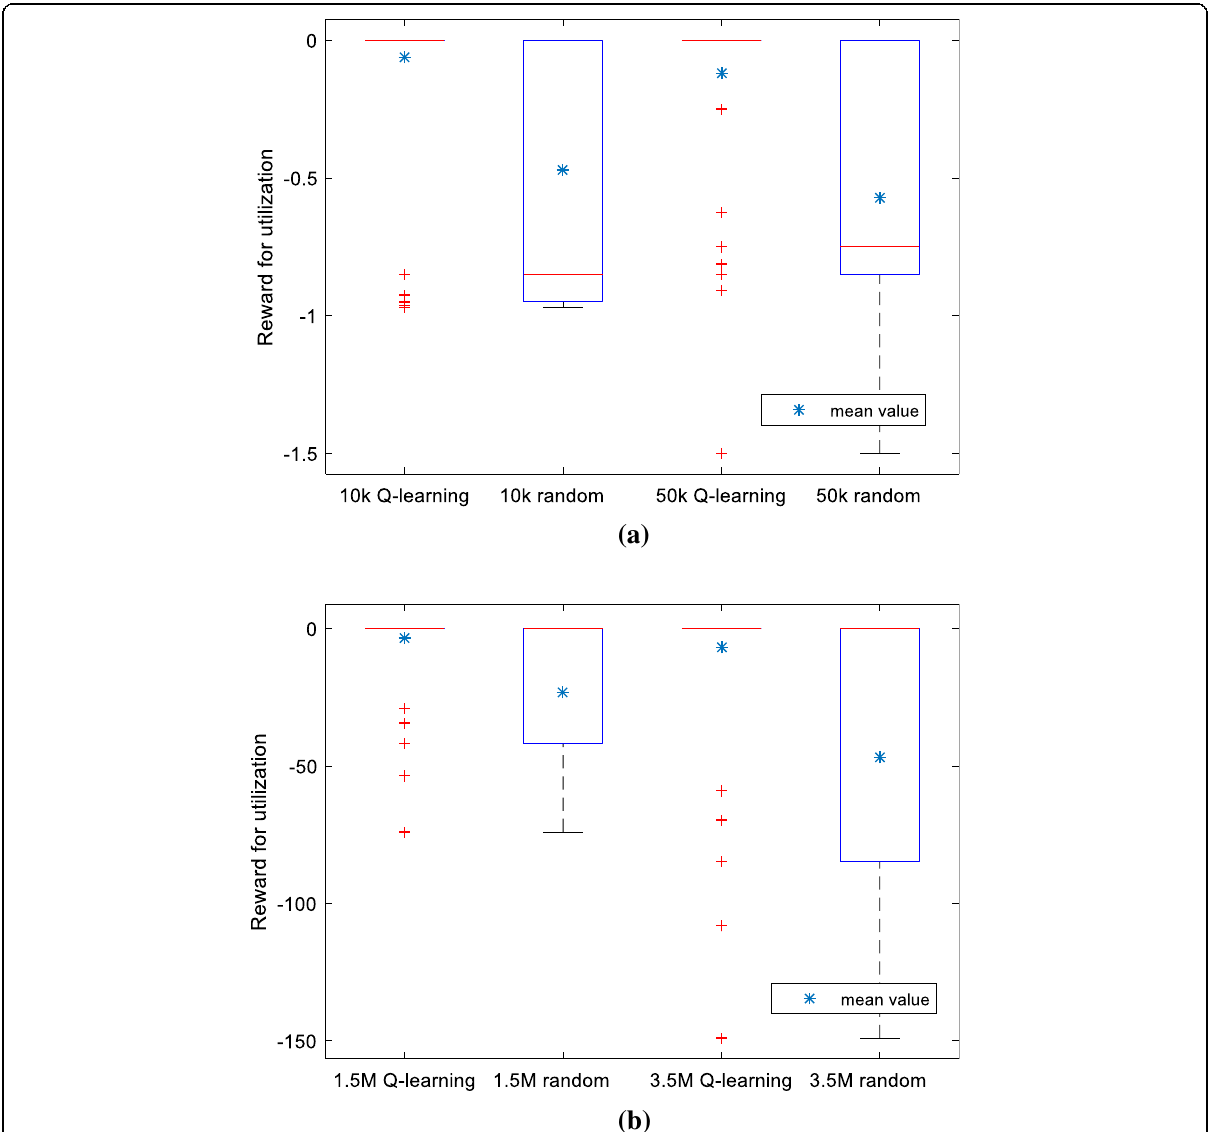
Fig. 20 The a mean and b boxplot of the reward for the channel utilization by the Q-learning and random selection at each DDR. For all DDRs, the boxplot of Q-learning has denser distribution and higher values than that of the random selection, and it has a higher average